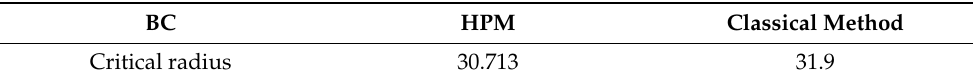
Table 13. Critical radius of two-group core part of reflected reactor.